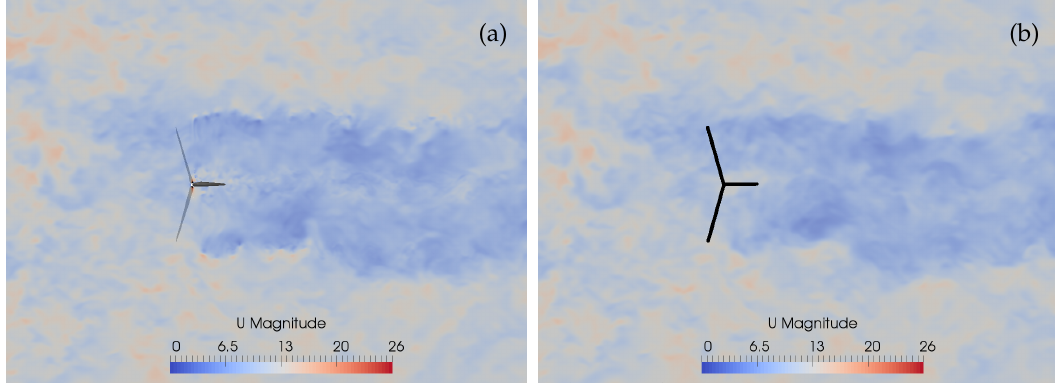
Figure 3. Snapshots of the velocity magnitude for ( a ) BR and ( b ) Actuator Line (AL) simulations.